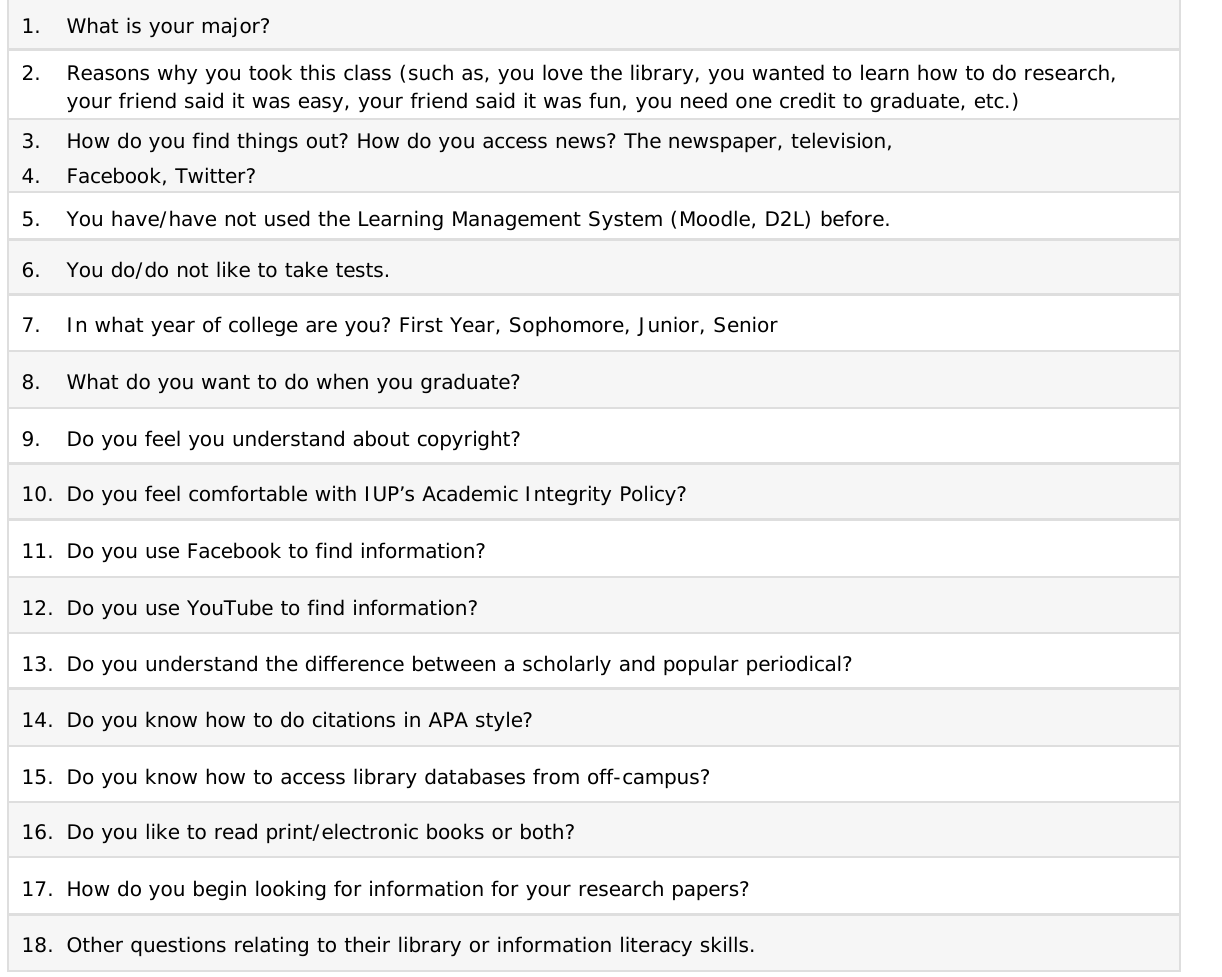
Sample questions used for “Getting to Know You